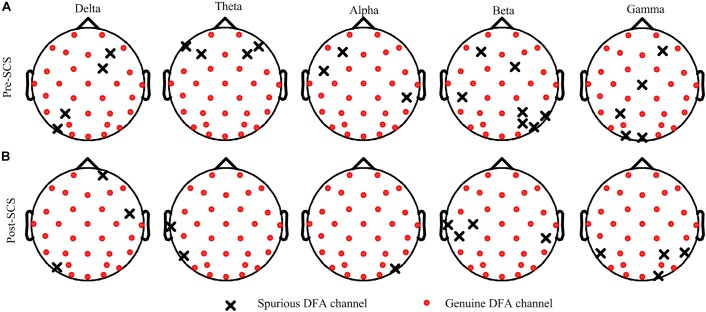
Surrogate data results for one participant (No. 7 in Table 1). (A,B) are the spatial distribution of the genuine and spurious DFA channels at five frequency bands, at pre- and post-SCS states. The solid red circle represents the genuine DFA channel and the black crosses represent the spurious DFA channel.